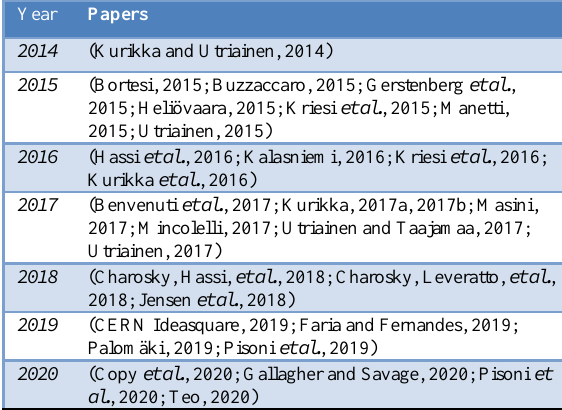
Tab 1. CBI-inspired programs literature